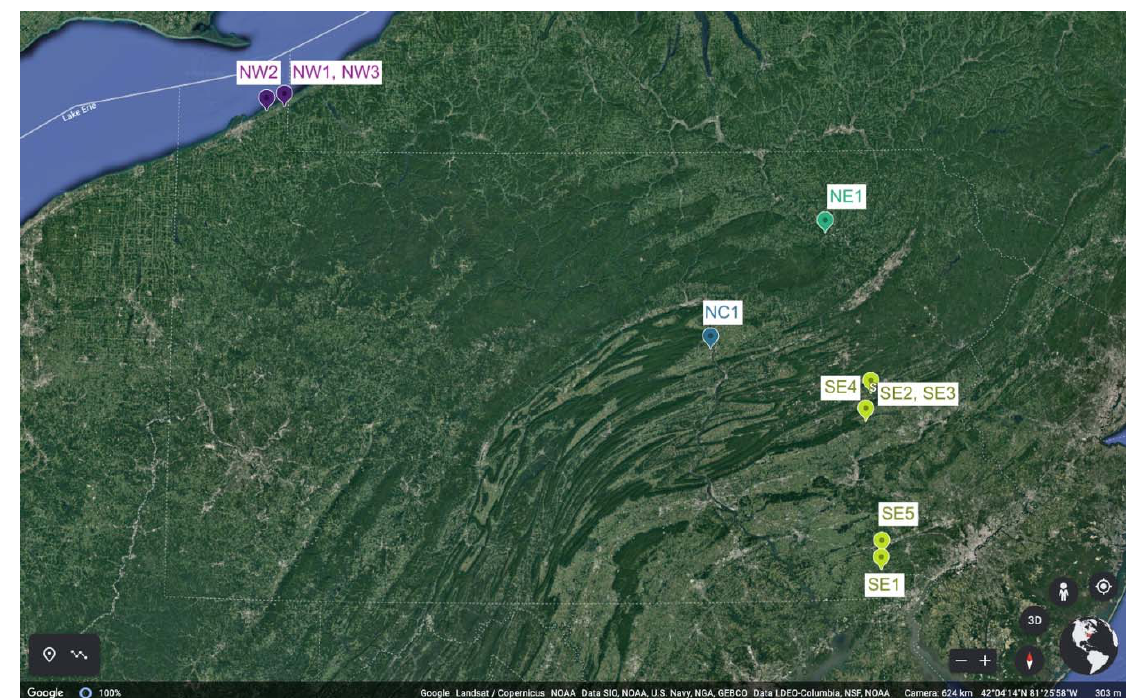
Figure 1. Location of vineyard sites within recognized regions of the Pennsylvania Winery Association (PWA; pennsylvaniawine.com, accessed on 10 April 2020). Vineyards with the same color belong to the same region.